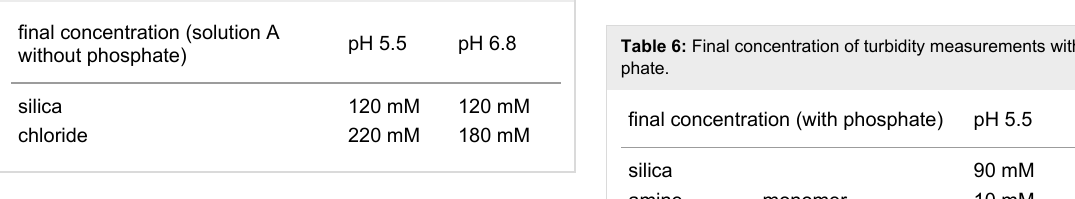
Table 2: Final concentrations of stock solution A without phosphate.